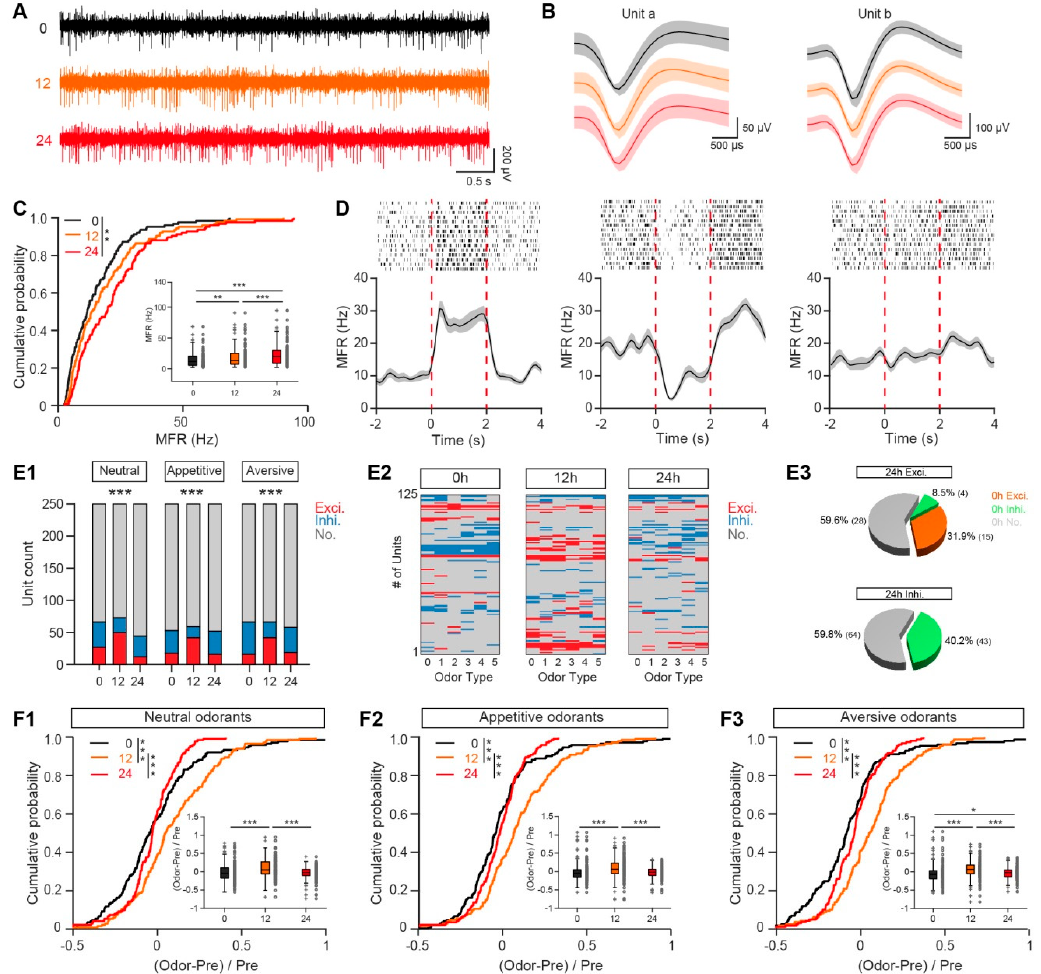
Figure 2. The firing of M/Ts recorded from the OB changes under different nutritional states. ( A,B ) Representative raw spike traces ( A ) and spike waveforms ( B ) recorded from a mouse fasted for 0 h (black), 12 h (orange), and 24 h (red) respectively. ( C ) Cumulative probability and box-and-whisker plot showing the spontaneous firing rate under different fasting states. Each gray circle represents the mean firing rate of a single unit. (Cumulative probability: Two-sample K-S test, 0 h vs.12 h, P = 0.31, 0 h vs. 24 h, P = 0.0012, 12 h vs. 24 h, P = 0.073. Box-and-whisker plot: Friedman’s test, χ 2 (2,248) = 65.10, P < 0.001, 0 h vs. 12 h, P = 0.0023, 0 h vs. 24 h, P < 0.001, 12 h vs. 24 h, P < 0.001). ( D ) Three examples of firing induced by isoamyl acetate when mice were in a satiated state. From left to right: an excitatory response, an inhibitory response, and no response. Top, raster plot. Bottom, peristimulus histograms for the firing rate, smoothed with a Gaussian filter with a standard deviation of 1500 ms. The red dotted lines indicate the period of odor stimulation. Error bars show the standard error of the mean (SEM). ( E ) The changes in the neural responses to odors under different fasting conditions. E1 . Stacked bar plots Neutral odorants (0 h, Excitory: 27/250, Inhibitory: 39/250, No response: 184/250; 12 h, Excitatory: 50/250, Inhibitory: 23/250, No response: 177/250; 24 h, Excitatory: 12/250, Inhibitory: 32/250, No response: 206/250). Chi-Square Tests: χ 2 (4) = 31.23, P = 0.000003, Exci. 0 h vs. Exci. 12 h, P < 0.05, Exci. 0 h vs. Exci. 24 h, P < 0.05, Exci. 12 h vs. Exci. 24 h, P <